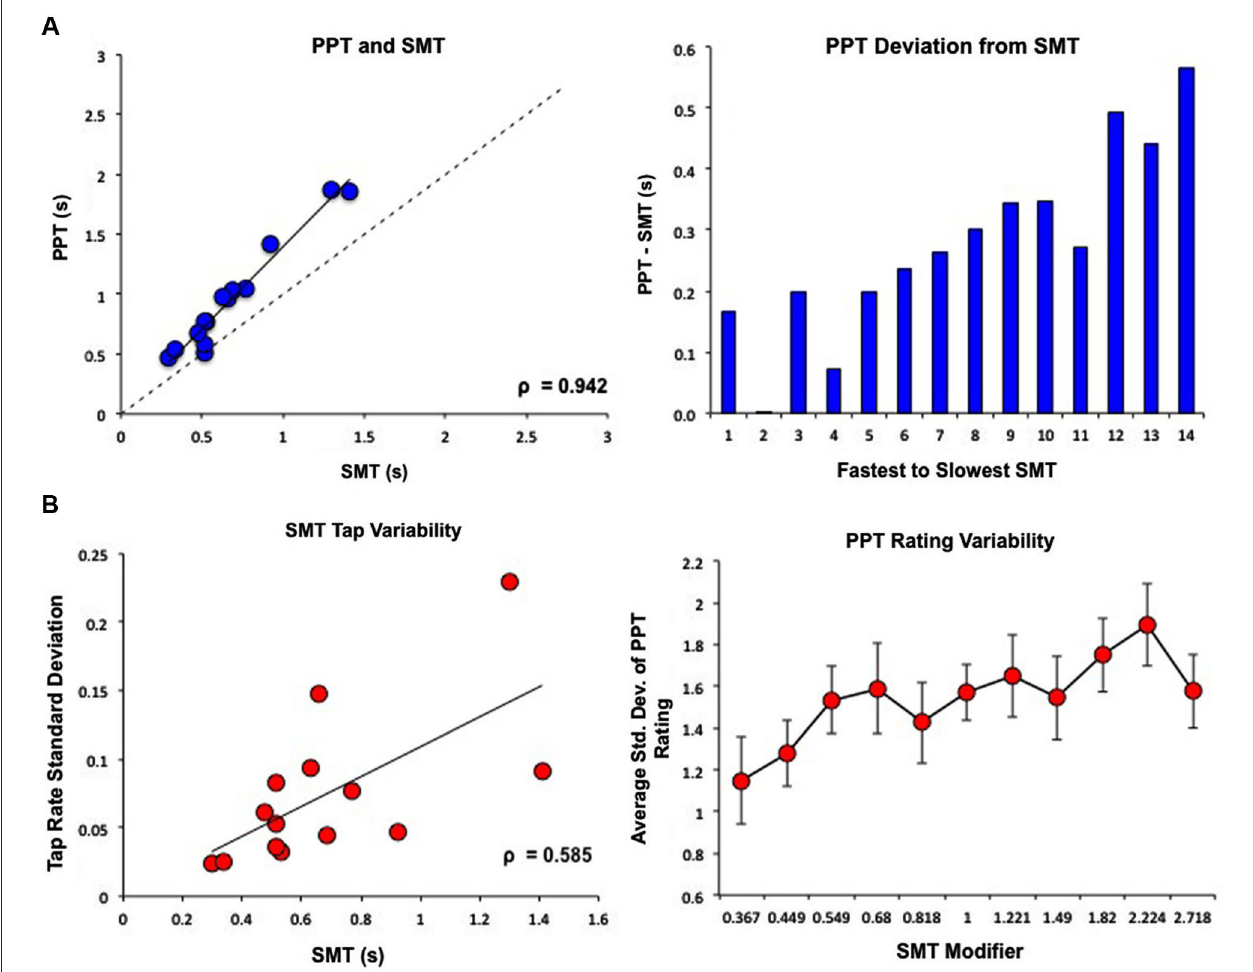
the log-spaced tempos of the tone sequences. This means that 1 = SMT, smaller values designate faster tempos, and higher values designate slower tempos. These modifier values were the same for each subject while the actual tempos changed depending on the subjects’ SMTs. Subjects with slower SMTs showed greater variability in tap rate. Similarly, subjects were more variable in their perceptual ratings of slower